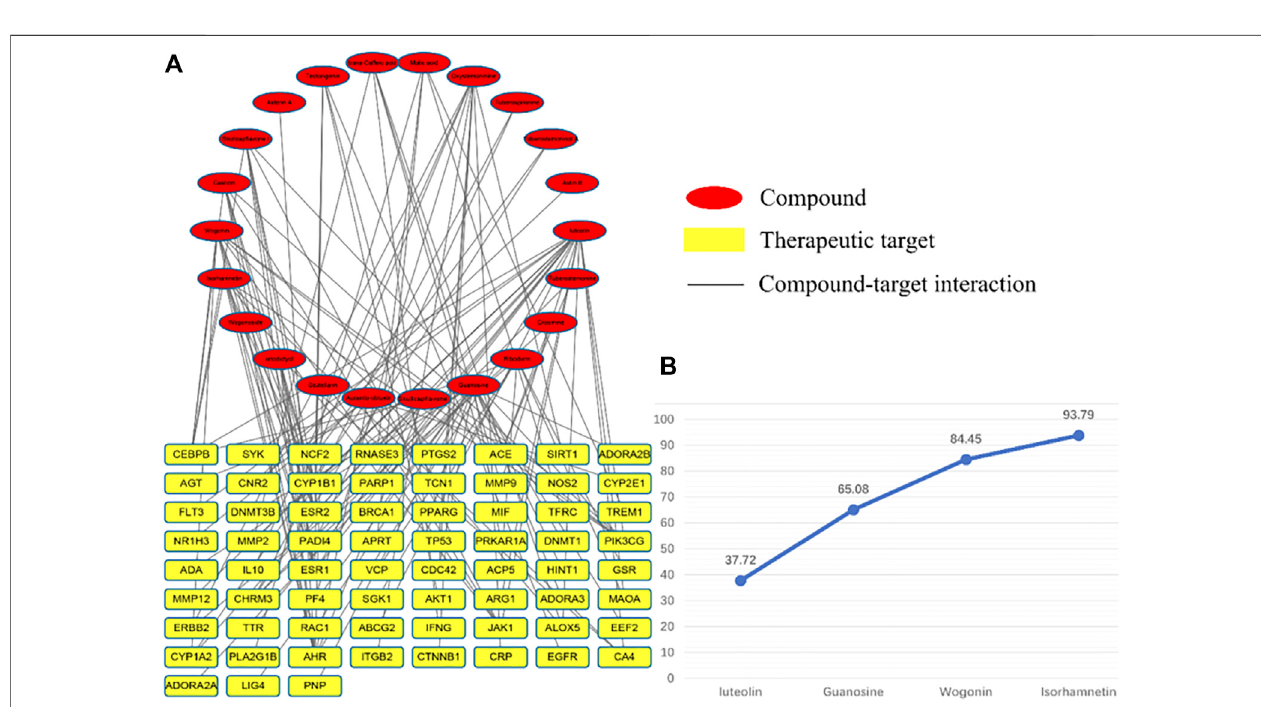
FIGURE7| C-Tnetworkdiagram,redrepresentscomponentsandyellowrepresentstargets. (A) isthecontributionofeachcomponenttotheC-Tnetworkand (B) is the four core components that contribute more than 85%.